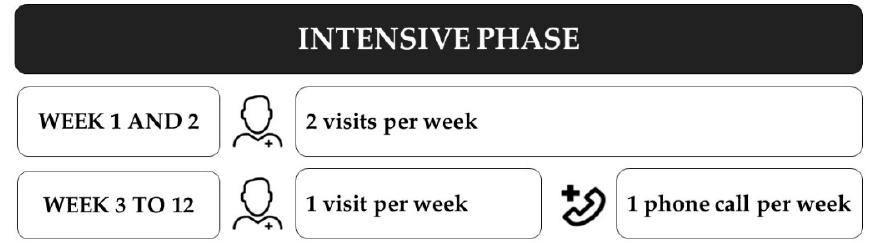
Figure 2. Standard number of visits and phone-calls during the intensive phase.